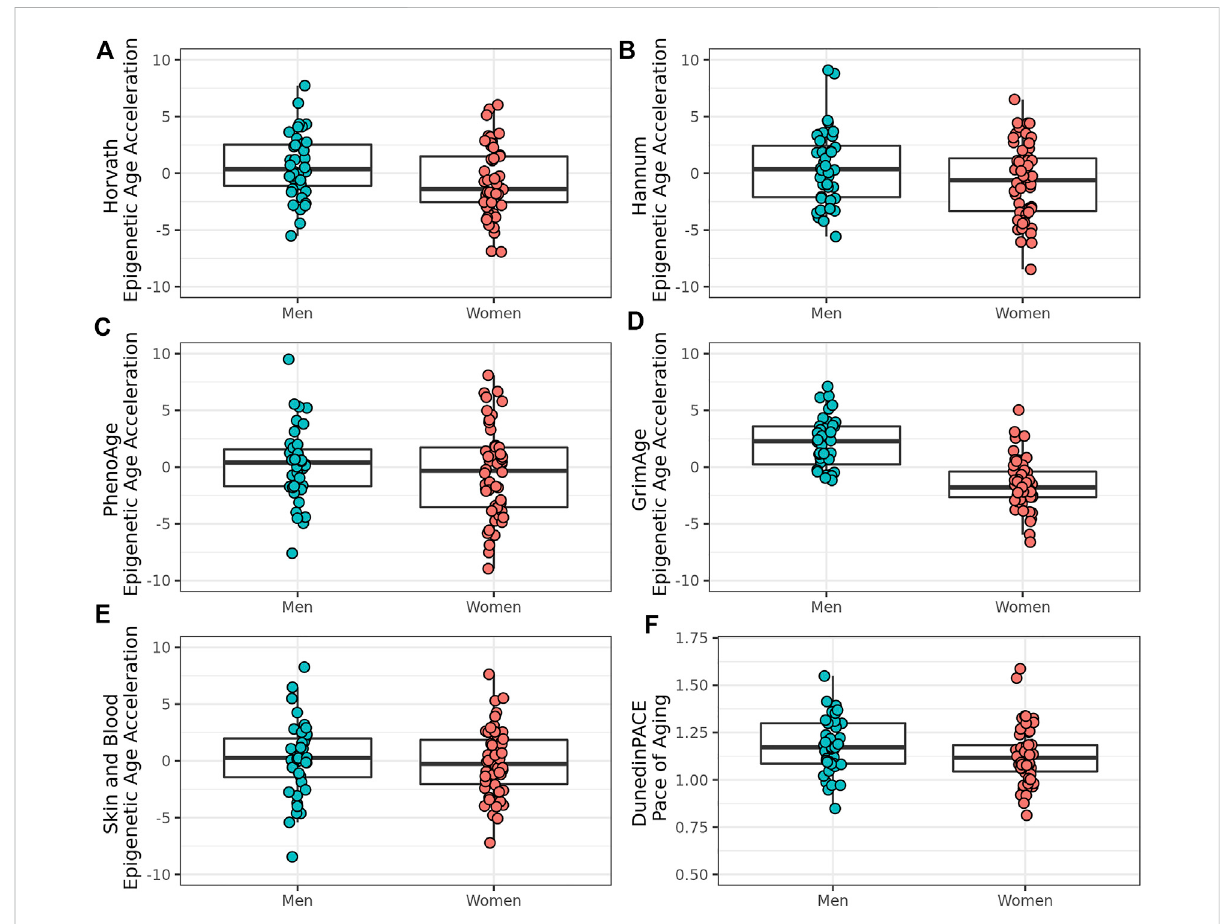
FIGURE 3 Epigenetic age acceleration and Pace of Aging in male and female residents of the Mediterranean Blue Zones, according to the (A) Horvath, (B) Hannum, (C) PhenoAge, (D) GrimAge, (E) Skin and Blood, and (F) Pace of Aging predictors.